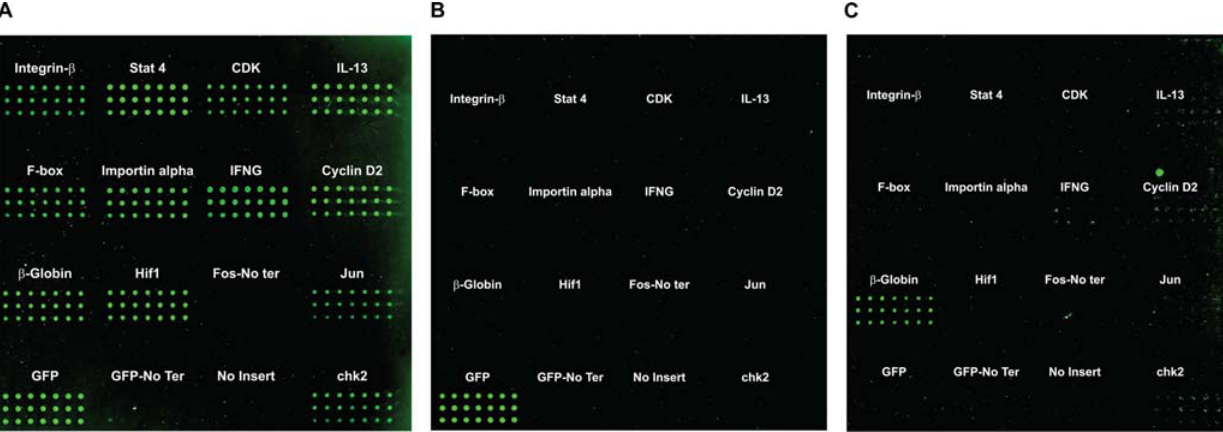
Figure 3. Microarray feature expression and capture specificity. pNOMut variants encoding different proteins fused to TUS - poly-histidine were immobilized on the surface of a microarray and incubated in a cell-free rabbit reticulocyte transcription/translation extract. Duplicate microarrays were then hybridized with cy-labeled monoclonal antibodies specific for A) His, B) GFP, and C) human B -globin.